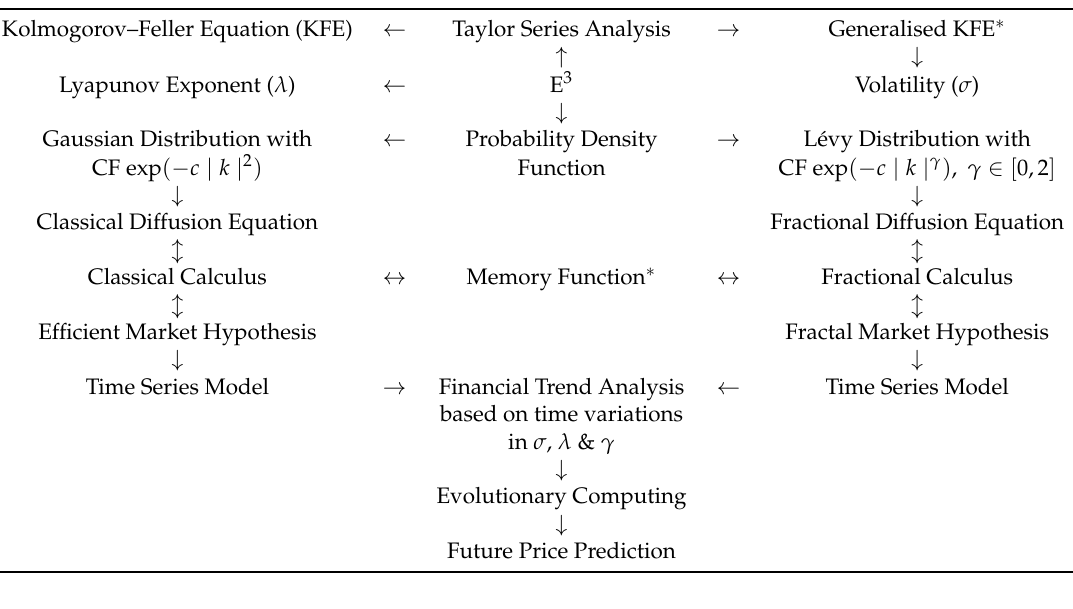
Table 1. Fow diagram illustrating the connectivity between Einstein’s Evolution Equation (E 3 ), two well known financial indices (i.e., the volatility σ and Lyapunov exponent λ ) and the classical and fractional diffusion equations both of which can be derived from the evolution equation using the Characteristic Functions (CFs) shown (where c is a constant, k is the spatial frequency and γ is the Lévy index). The flow diagram also illustrates the relationship between the evolution equation and two principal market hypotheses: the efficient market hypothesis and the fractal market hypothesis, the latter hypothesis being a concomitant of the fractional calculus. The asterisk ( ∗ ) denotes the connection between the Generalised KFE and the introduction of a memory function which allows E 3 to be written in a different form without loss of